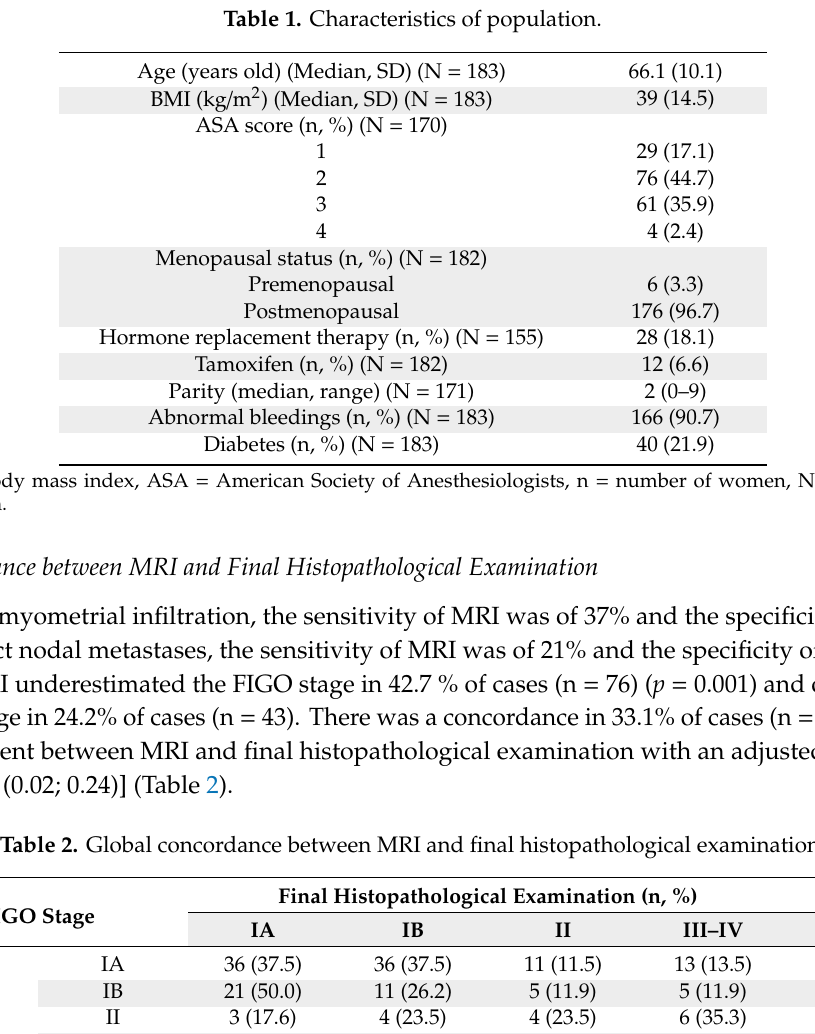
FIGO = International Federation of Gynecology and Obstetrics, MRI = magnetic resonance imaging, n = number of women, N = total number of women. Adjusted Kappa of 0.12 [0.018;